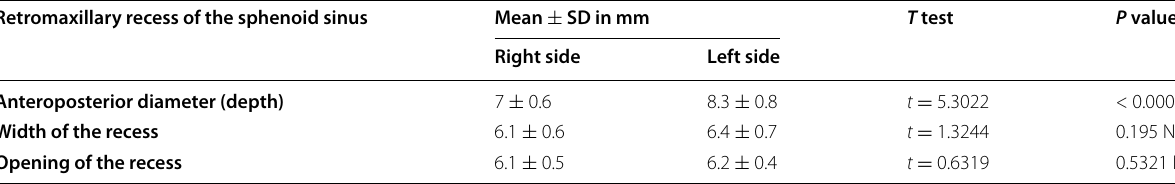
SD standard deviation, S significant, NS non‑significant